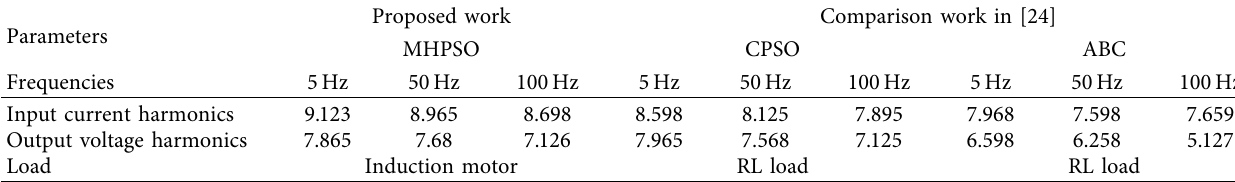
Table 4: Proposed and literature methods.